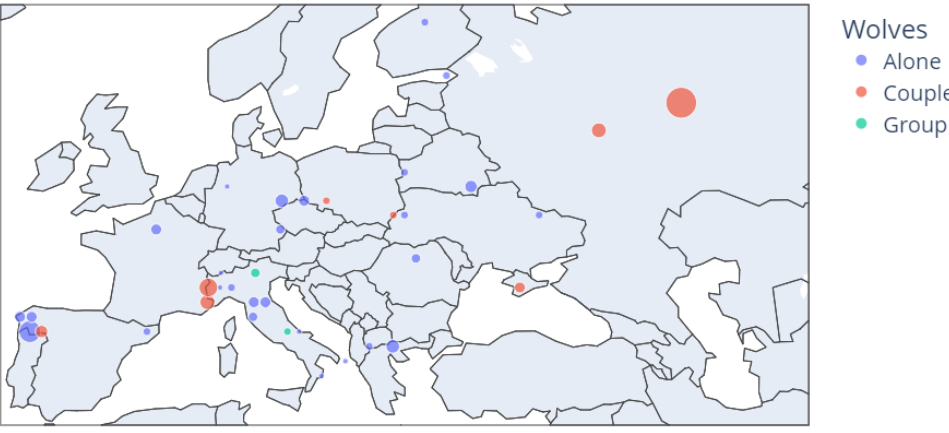
Figure 5. Iberian wolves detected in Europe. Bubble size depends on the number of